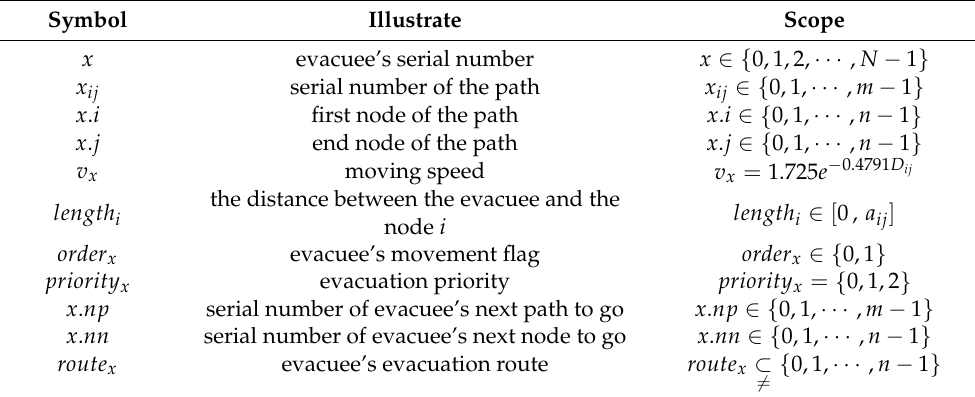
Table 4. Evacuee’s attributes and